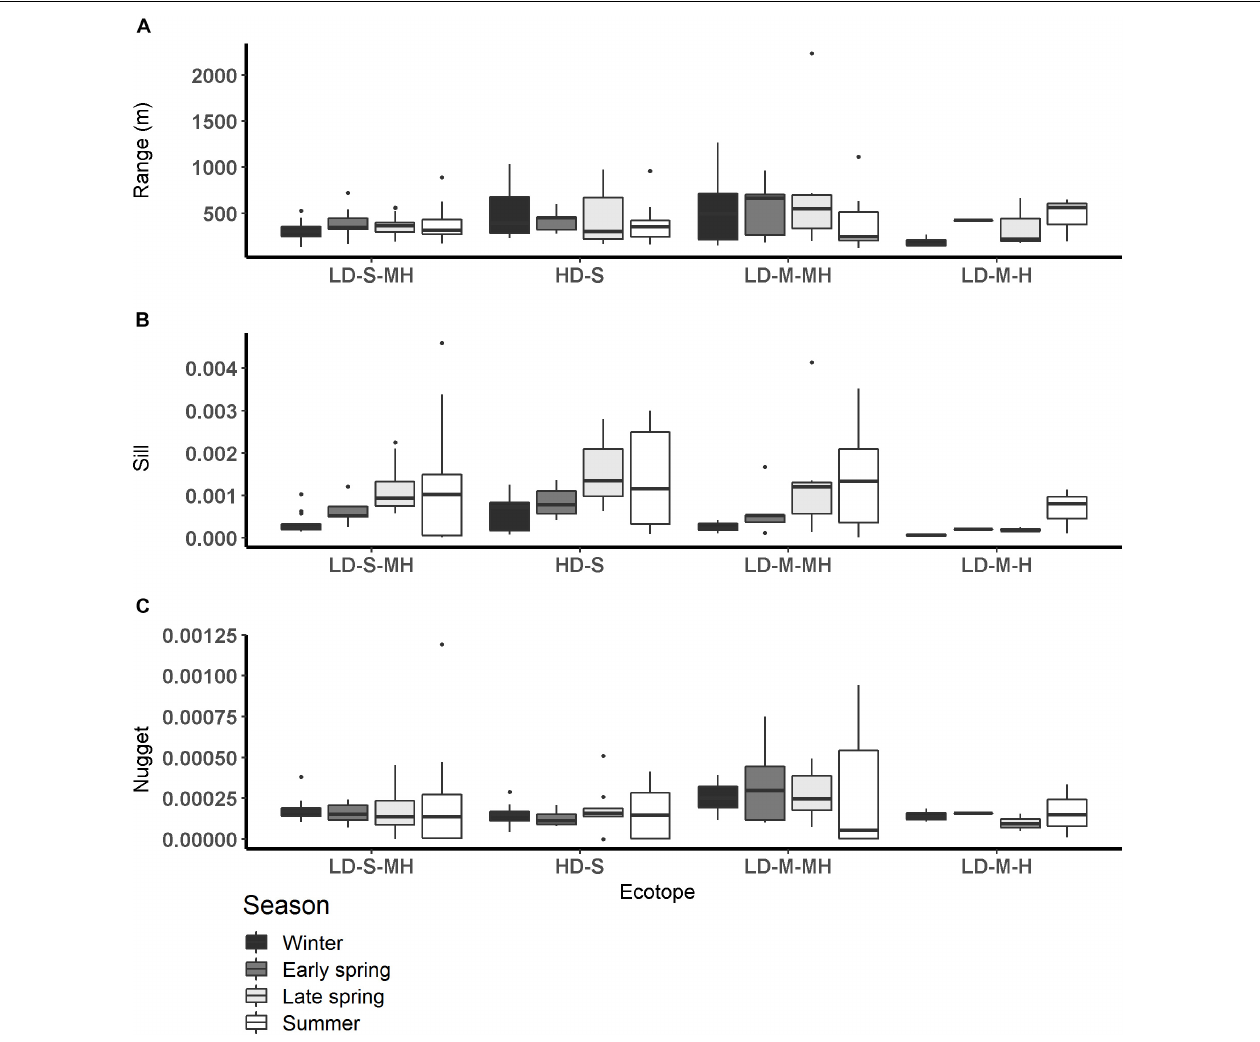
FIGURE 5 | Semi-variogram parameters per season per ecotope ( A : range (m), B : sill, C : nugget). HD-S, Highly dynamic fine sand littoral; LD-S-MH, low dynamic fine sand medium high littoral; LD-M-H, low dynamic silt rich high littoral, and LD-M-MH, low dynamic silt rich medium high